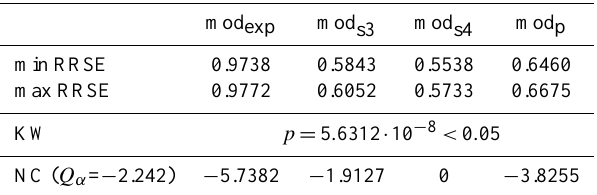
Table 2. Minimal and maximal RRSE values obtained during the cross-validation for the different models: the exponential-based function proposed by Famiglietti et al. (2008) (modexp), two spline functions with 3 and 4 knots respectively (mods3 and mods4), and a second order polynomial (modp). The results of the Kruskal-Wallis (KW) statistical test and the nonparametric comparison (NC) of a control group to other groups for a significance level α = 0 . 05 are given as well.